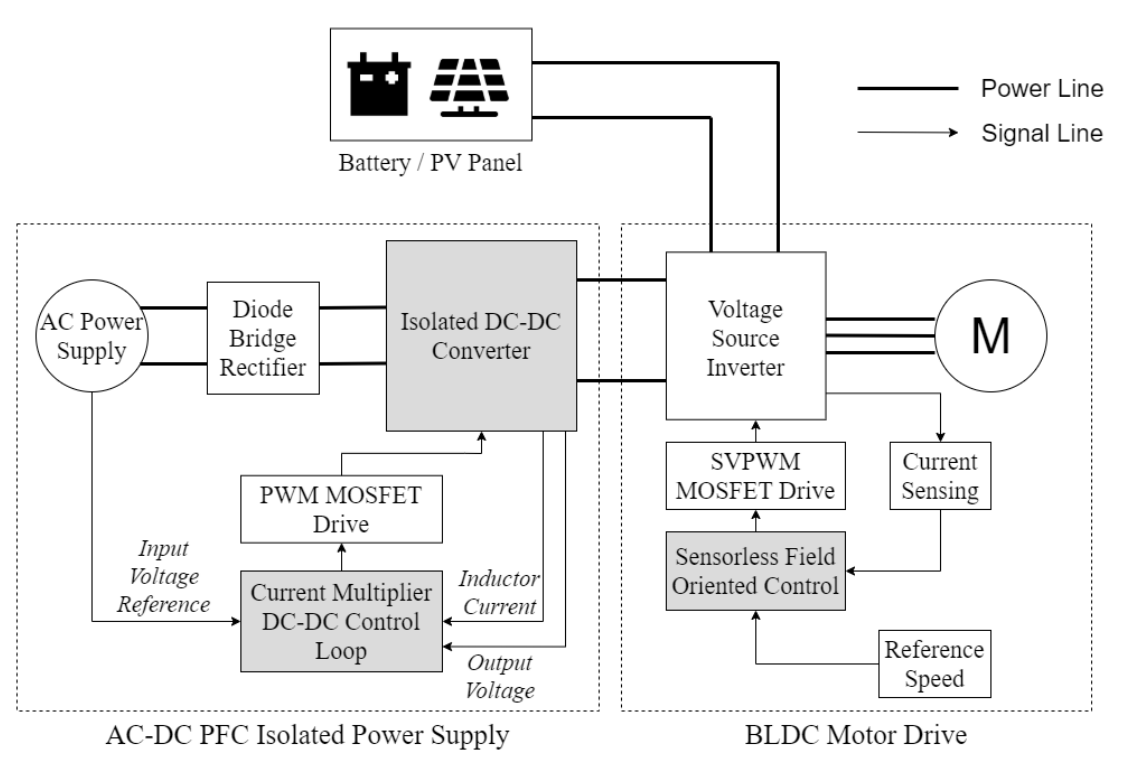
Figure 2. BLDC ceiling fan controller block diagram. Table 4. Required parameters for AC-DC supply in BLDC ceiling fan